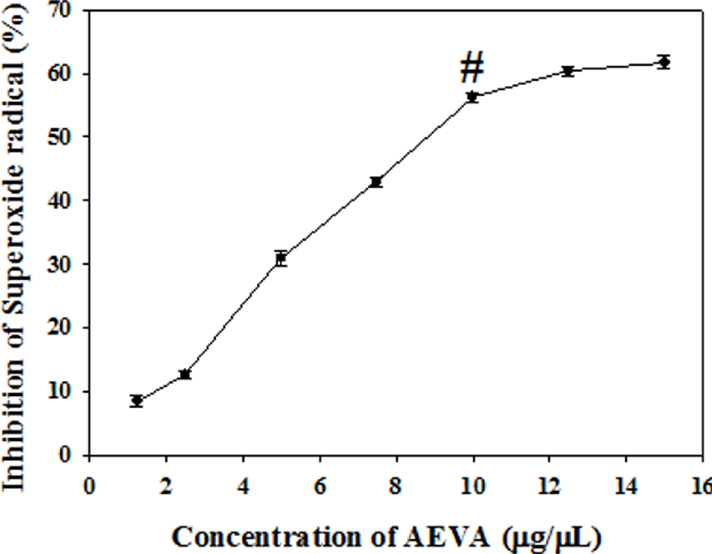
Fig 5. Superoxide radical scavenging activity of AEVA. Graph is obtained by plotting different concentrations of AEVA (1.25, 2.5, 5, 7.5, 10, 12.5, and15 μ g/ μ L) with respect to percent inhibition. “ # ” indicates the optimum concentration of AEVA at which it exhibits maximum inhibition. Values are mean ± SE (n =